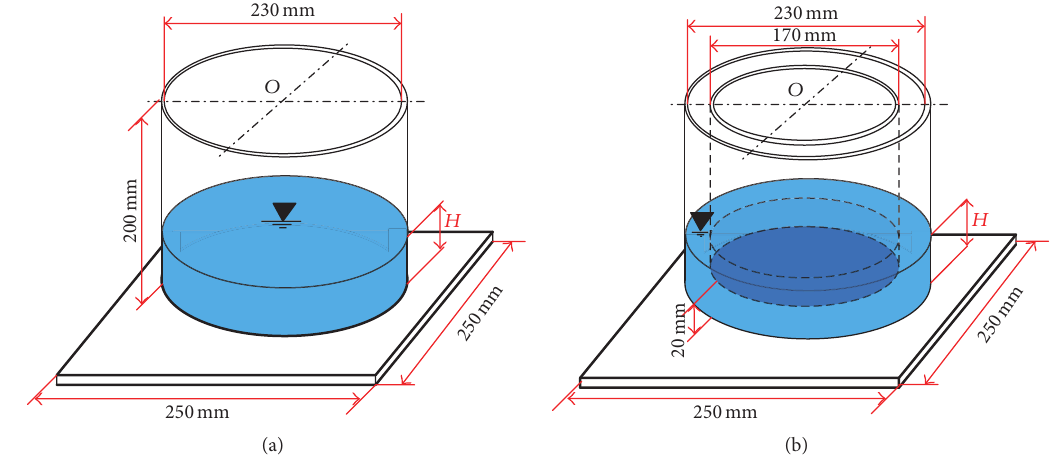
Figure 2: Two passive vibration control systems: (a) C-TLD and (b) C-TLCD.